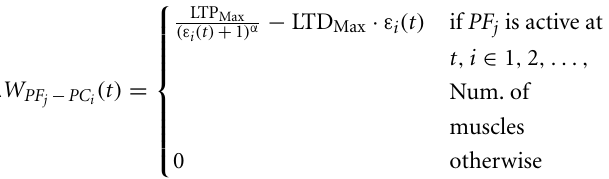
neurons. The figure presents two alternative coding strategies: in our model, there are no spikes and the states correspond directly to the offset from movement onset indicated by the time bin. Formally, this corresponds to passing from a sparse coding to a labeled-line coding . (B) Binary representation of activity in a PF subset (1: active synapses, 0: inactive synapses) and firing rates in the corresponding PC and DCN neuron (in PCs the values are normalized in the range 0–1). A low PC firing rate corresponds to a high DCN firing rate. (C) Block diagram of the elements involved in the model. A state generator (which is reinitialized with the onset of a new trial) mimics the functionality of the cerebellar granular layer. A state-error correlator emulates the PC function: PF-PC long-term plasticity under supervision of CFs. Finally, an adder/subtractor receives the inputs coming from the MFs (multiplied by the MF-DCN synaptic weights) and subtracts the signal coming from the PCs (multiplied by the PC-DCN synaptic